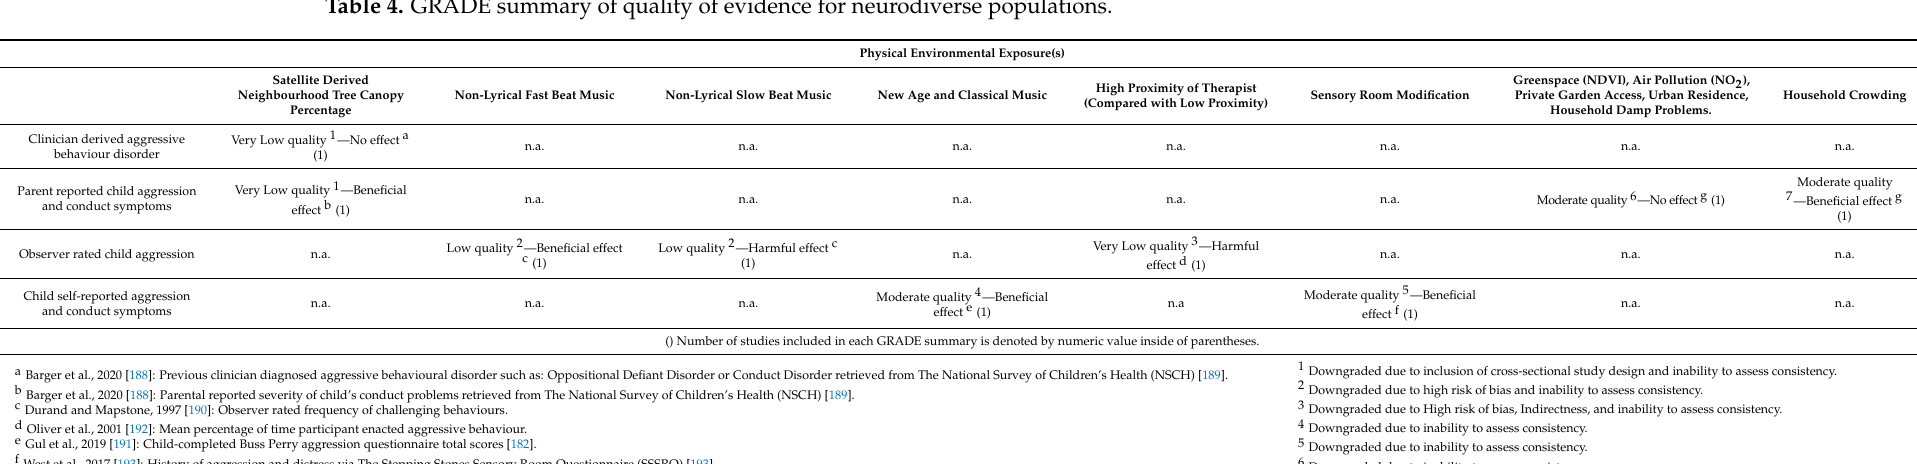
Table 4. GRADE summary of quality of evidence for neurodiverse